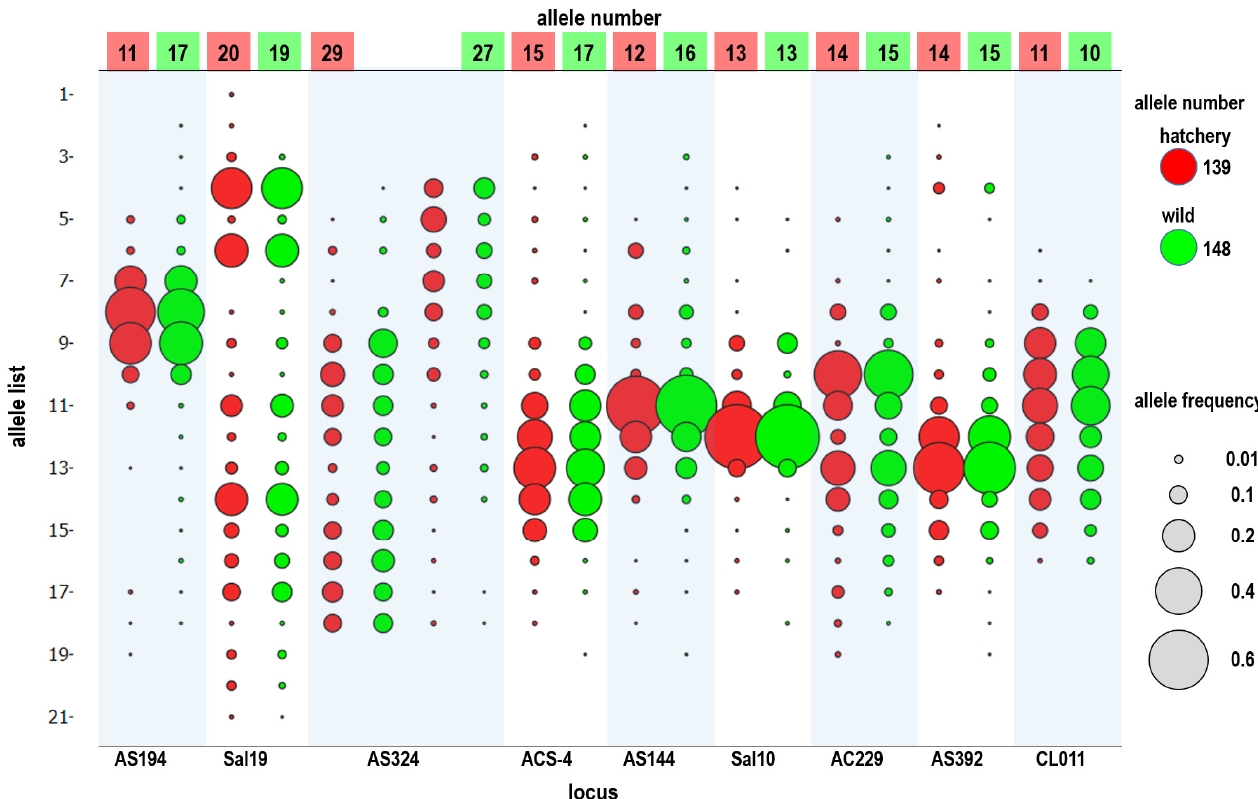
Figure 3. Allele frequency of nine microsatellite loci in hatchery ( n = 388) and wild ( n = 739) black sea bream populations in Taiwan. Hatchery: KS_C1, KS_C2, KS_C3, PR_C1, PR_C2, KM_C, and MT_C; Wild: ML_W1, ML_W2, ML_W3, YL_W, PH_W, TN_W, TP_W, KM_W, and